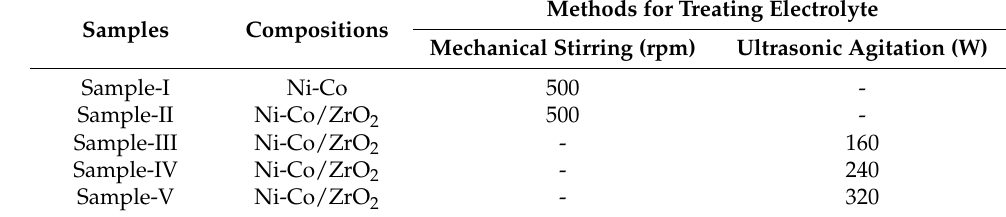
Table 2. Mechanical and ultrasonic agitation parameters for creating alloy coated samples.